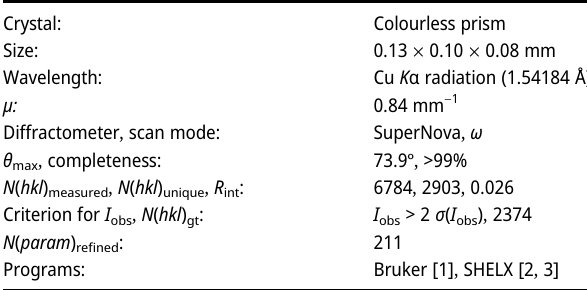
Table 1 contains crystallographic data and Table 2 contains the list of the atoms including atomic coordinates and displacement parameters.